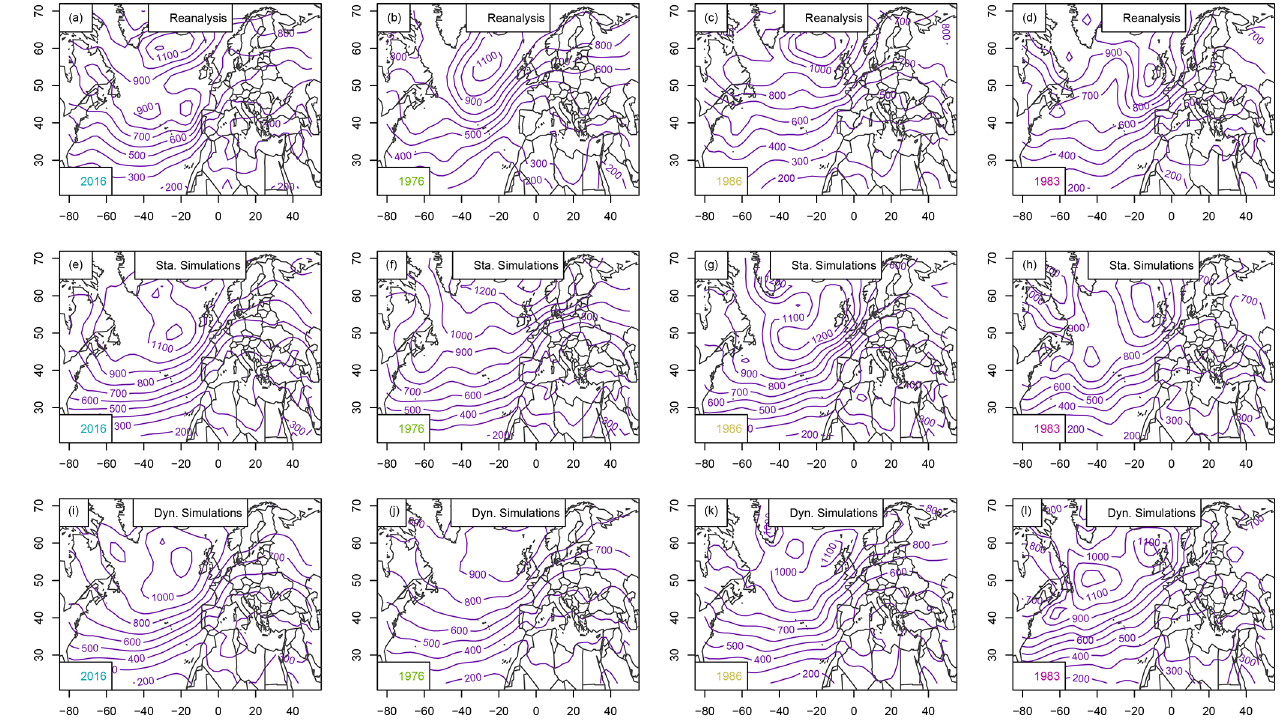
Figure B1. Standard deviation of daily SLP anomalies (Pa) for April–July 2016, the driest period, the median (1986), and 2018: (a–d) SLP from NCEP reanalyses, (e–h) static SWG simulations, (i–l) dynamic SWG simulations. For the SWG simulations the average of all 1000 runs for the given year is